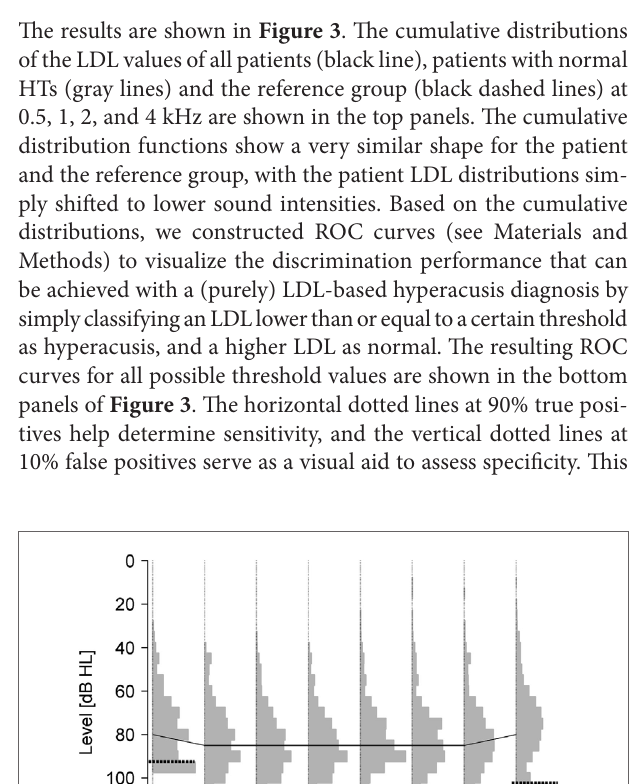
FigUre 3 | comparison of patient lDls to a normal-hearing reference group (12) . Top panels: Cumulative LDL distributions. Black solid lines – all patients; gray solid lines – patients with normal hearing thresholds; black dashed lines – reference group. Dotted lines indicate 10 and 90% level. Bottom panels: Receiver operating characteristic curves (see Materials